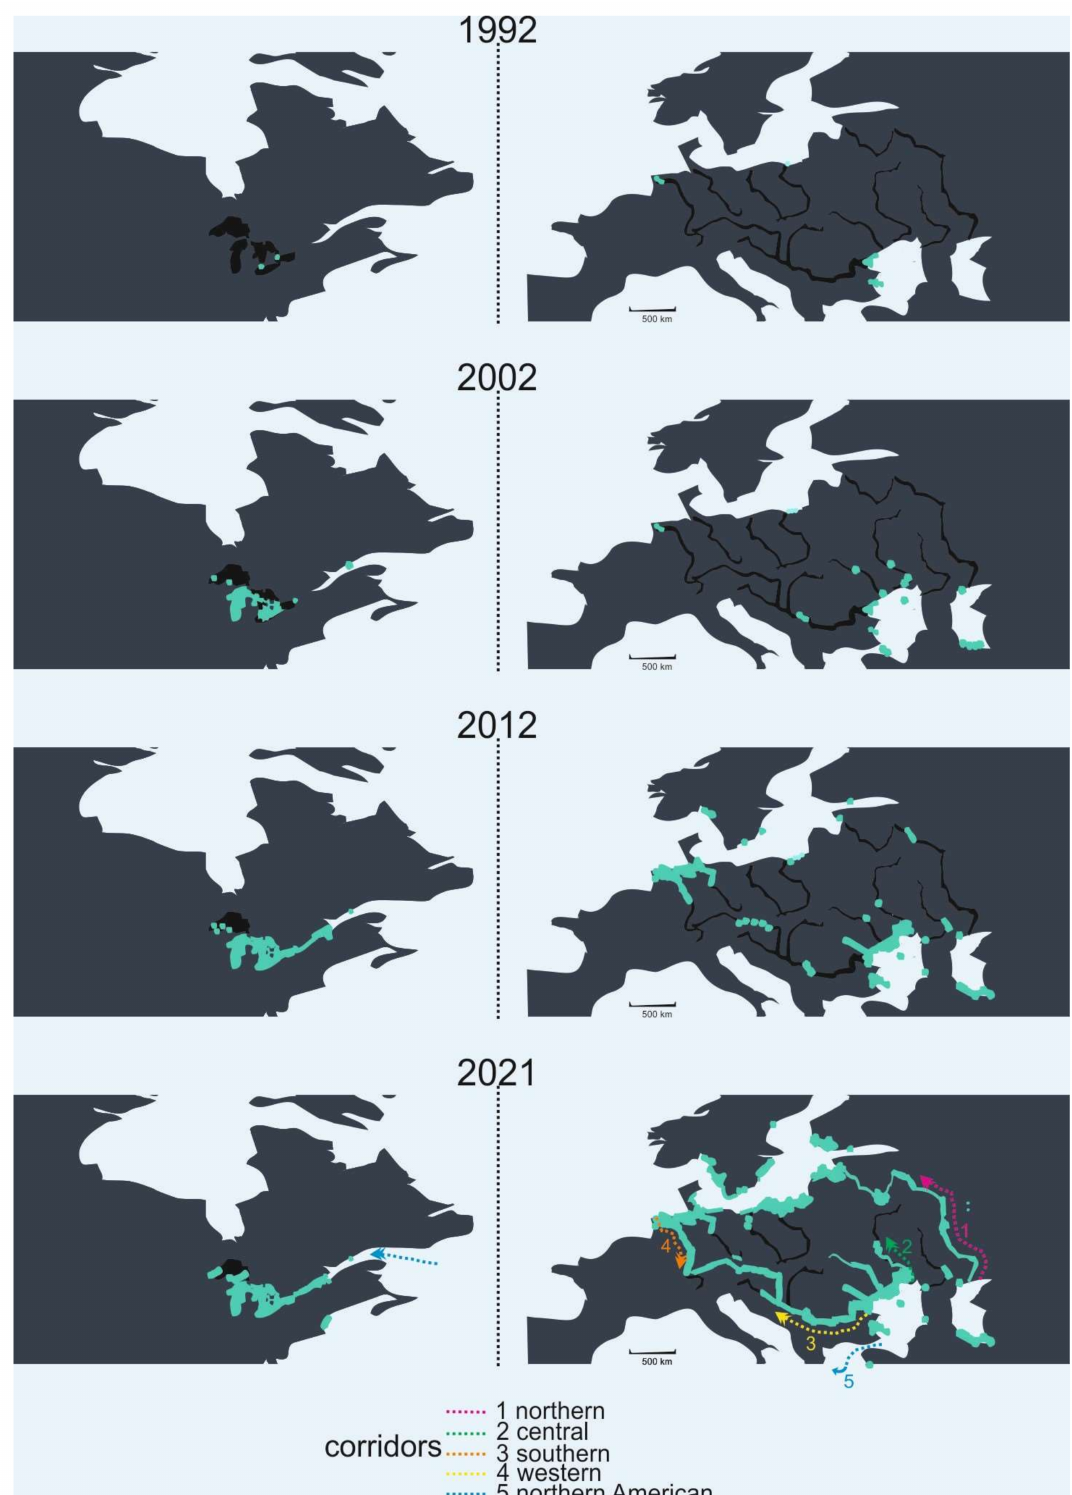
Figure 2. Range expansion of the round goby (Neogobius melanostomus ) in North America (left panels) and Europe (right panels) along major corridors (2021: 1–5, marked in different colors) over the last 30 years. The green dots indicate reported round goby occurrences compiled from multiple sources; distribution patterns are presented in 10-year sequences from 1992 through